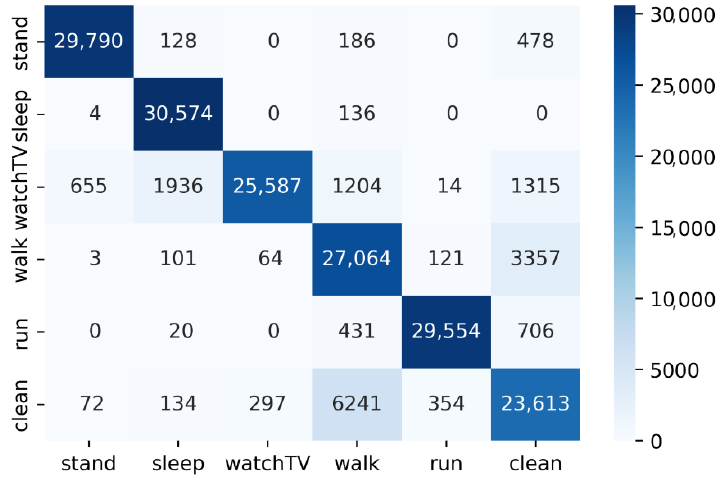
Figure 6. Confusion matrix of the GRU + CA + TA model on the datasets without I.I.D.